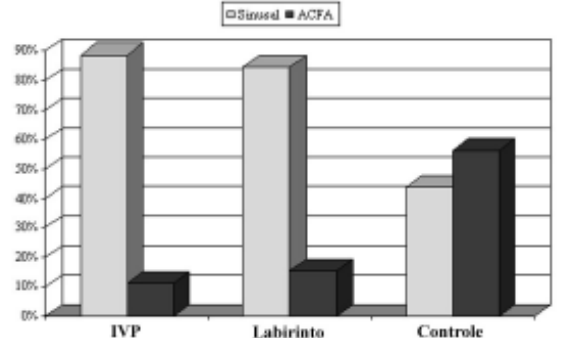
Fig. 2 - Ritmo tardio por